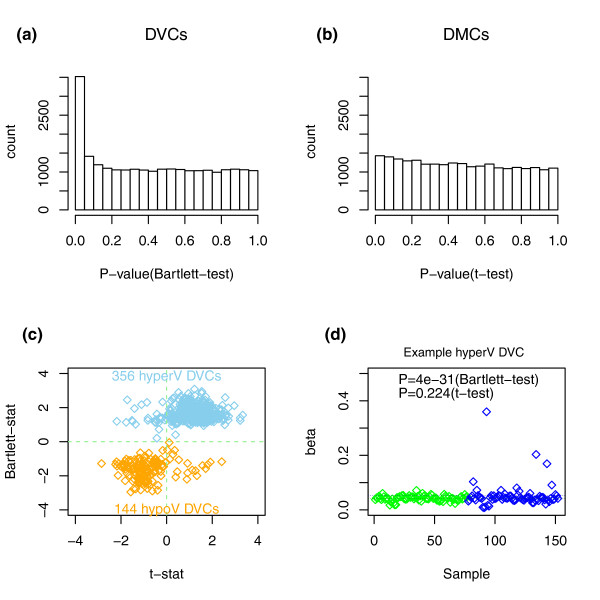
Differentially variable and differentially methylated CpGs. (a) Histograms of P-values derived from Bartlett's test comparing differences in variance between normal samples that become neoplastic (CIN2+) and samples that remain normal (differentially variable CpGs (DVCs)). (b) Histograms of P-values derived from t-tests comparing differences in mean CpG methylation levels between the same two phenotypes (differentially methylated CpGs (DMCs)). (c) Scatterplot of Bartlett statistics (logarithm of the ratio of the variance in prospective CIN2+ to that in normal) shown on the y-axis against the corresponding t-statistics (x-axis) for the top 500 DVCs. The numbers of hypervariable (hyperV) and hypovariable (hypoV) DVCs are given. (d) Typical methylation profile of a hypervariable DVC (blue = prospective CIN2+, green = normal). The thin dashed lines indicate the mean levels of methylation in each phenotype. The P-values shown are from a Bartlett's test (differential variability) and t-test (differential methylation).